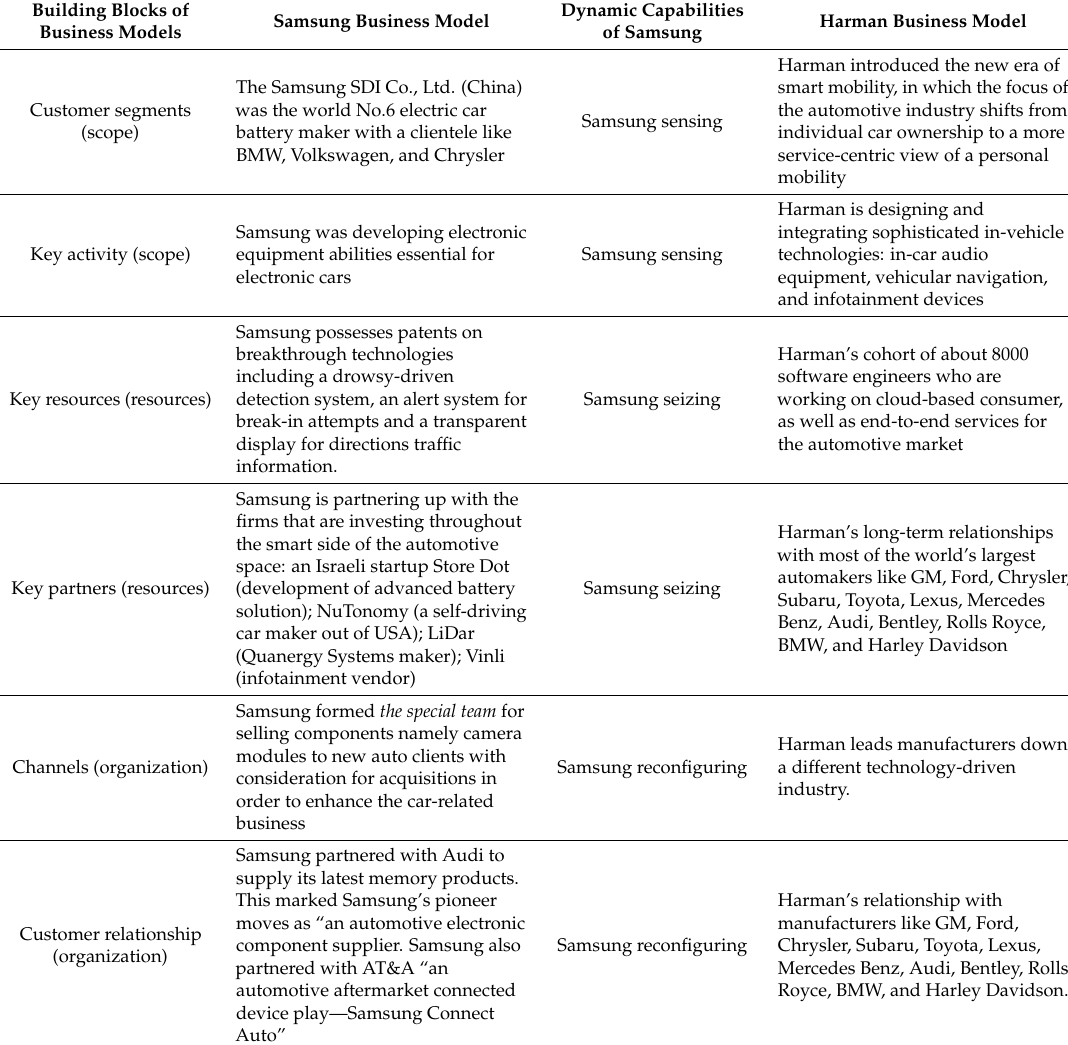
Table 3. The role of dynamic capabilities of Samsung as drivers of the business model innovation in the acquisition of